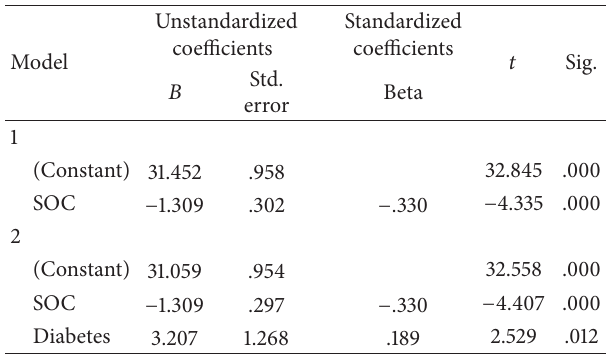
Table 1: Predictors of BMI. Table 2: Predictors of a DASH diet plan.